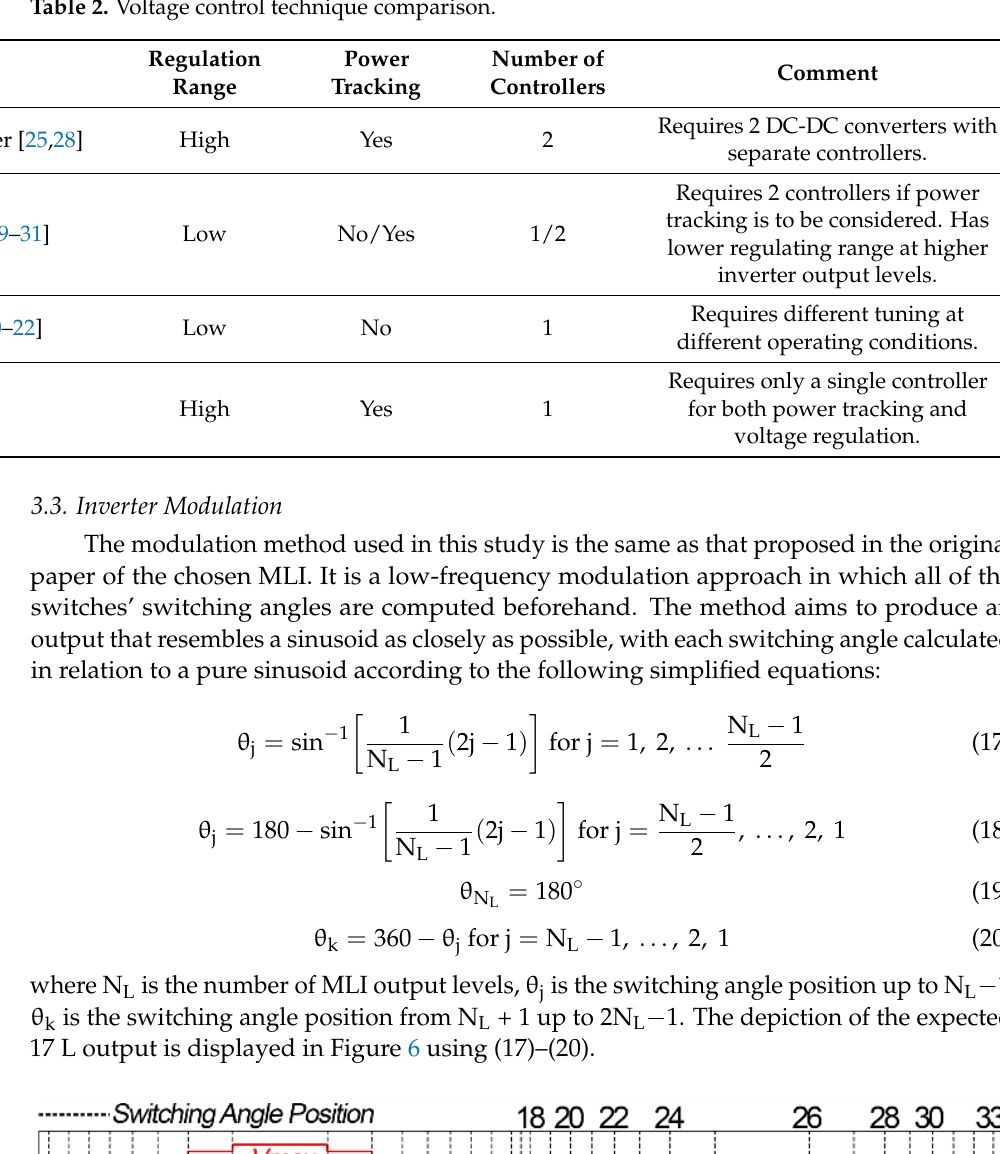
Table 2. Voltage control technique comparison.